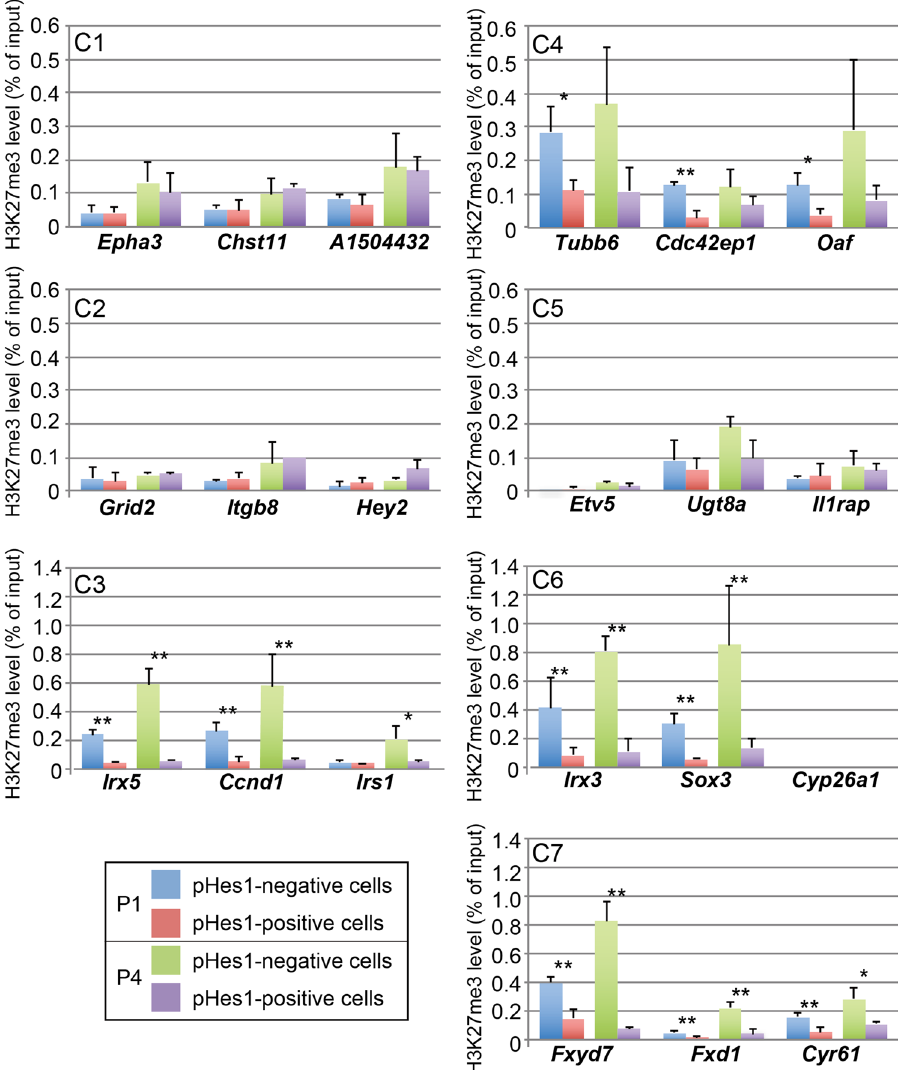
Figure 4. H3K27me3 levels of pHes1_EPC-specific genes loci in pHes1-EPC and pHes1-ENC. H3K27me3 levels of representative genes of each cluster in pHes1-EPC and pHes1-ENC at P1 and P4. ChIP using anti- H3K27me3 antibody was done using extracts of purified pHes1-EPC and pHes1-ENC from mouse retina at P1 and P4. qPCR was done using representative genes in each cluster. The experiments were done three times, and values are average of three samples with standard deviation. p value; ** < 0.01, * < 0.05, or n.s. > 0.05 was calculated by Student’s